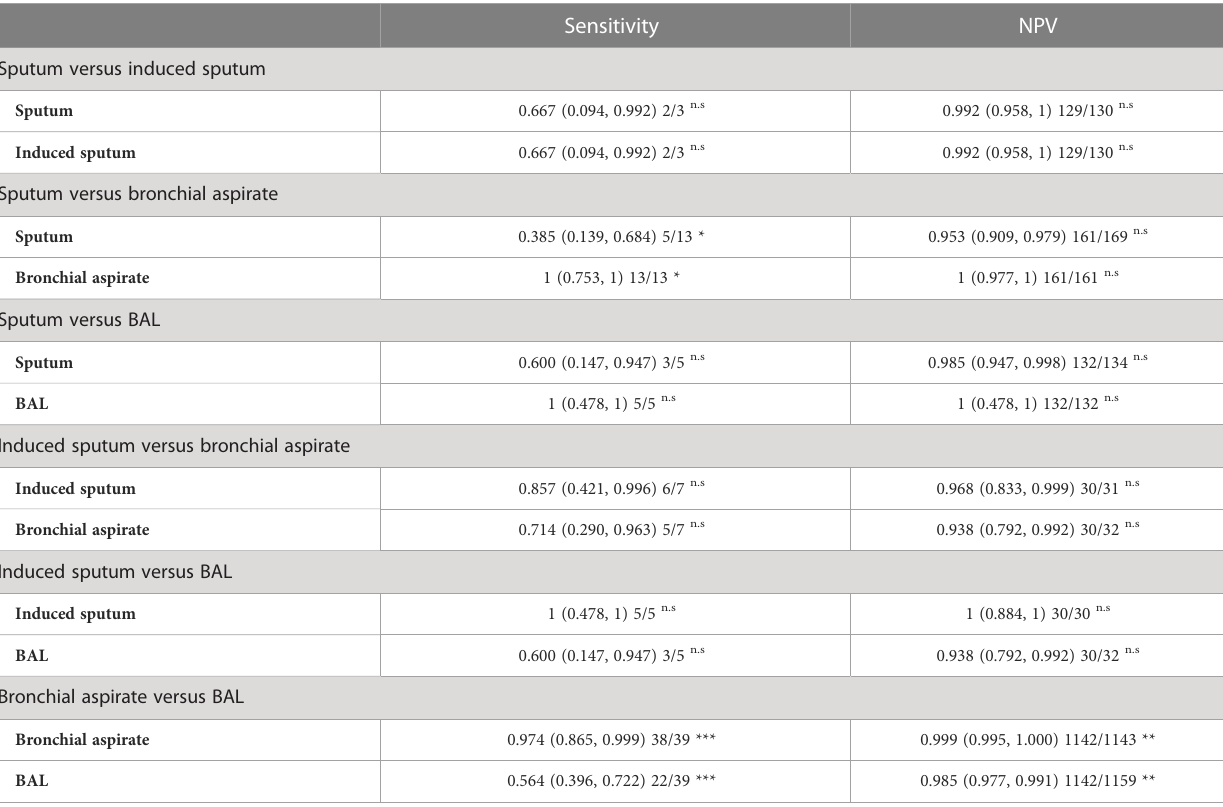
TABLE 5 Sensitivity of PCR to predict tuberculosis according to the type of specimen using a 72-hours pairing window in the same patient.